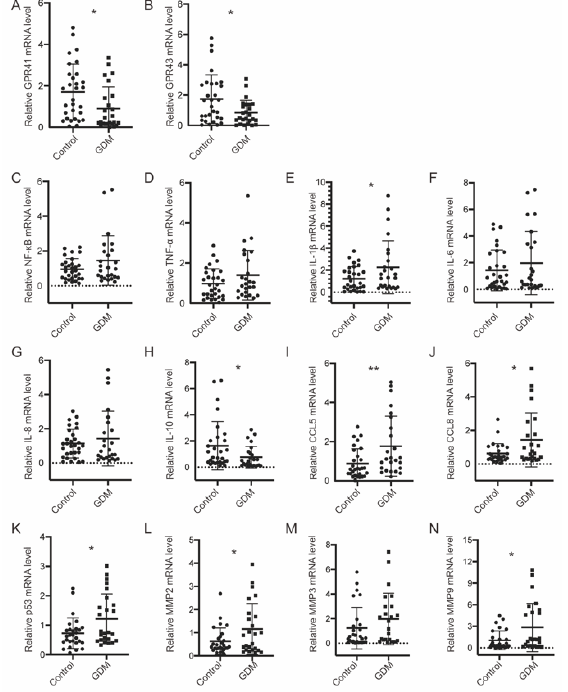
Figure 6. GPR41 and GPR43 were decreased, accompanied by enhanced proinflammatory responses in GDM pregnancies. ( A , B ) mRNA levels of GPR41/43 measured by real-time PCR. ( C – N ) mRNA levels of cytokines measured by real-time PCR. Data are presented as the mean ± SD. * p < 0.05, ** p < 0.01, significant difference vs. control group. GPR41, G-protein-coupled receptors 41; GPR43, G-protein-coupled receptors 43.